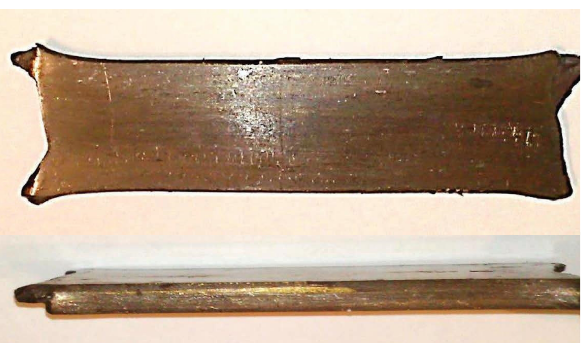
Figure 5: Te sample shape after the TE and after the frst stage of subsequent billet rolling. Sample dimensions after deformation: thickness is 9.7mm, width is 44mm, and length is